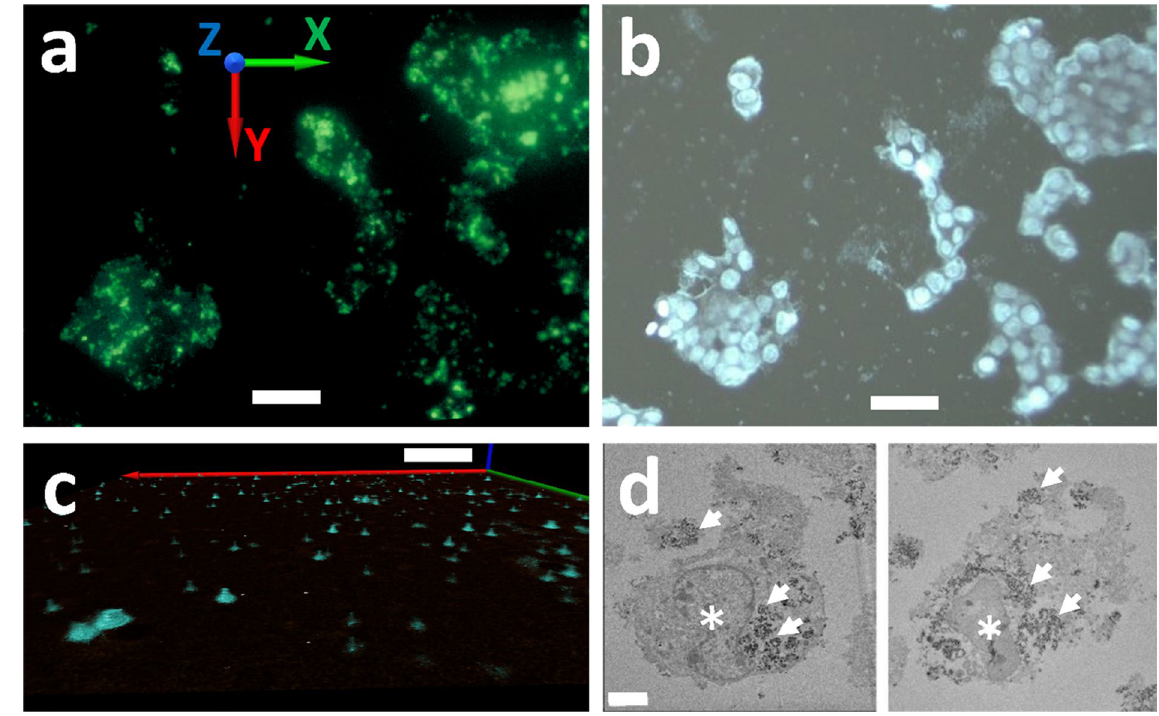
Figure 3. HCT 116 cells cocultured with SciNPs. ( a ) 3D reconstructed MAXWELL image. ( b ) image of the same sample taken with UV irradiation. Note that the color was presented from the 3D visualization process and does not represent the emission color of the SciNPs. ( c ) MAXWELL image of HCT 116 cells loaded with SciNPs. The z- direction has a scale 5 times larger than the xy -directions to show the 3D structure of the SciNPs. Note that particles appear distributed in the same plane because the cultured cells spread on the glass substrate, their distribution becoming very thin in the z -direction. ( d ) TEM images of an HCT 116 cell revealing that many NaGdF 4 :Eu (left) and NaGdF 4 :Tb (right) nanoparticles were internalized in the cytoplasm. The cell nuclei are marked by asterisks. Scale bars: ( a,b ) 50 µm; ( c ) 10 µm; ( d ) 5